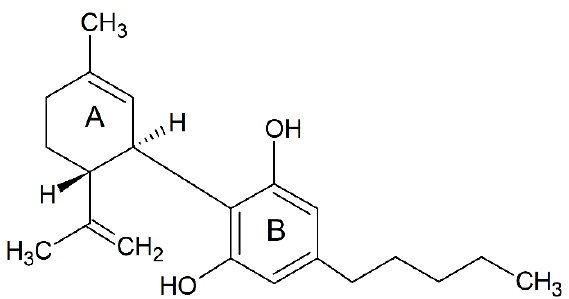
Figure 1. The chemical structure of the naturally occurring CBD (drawn from